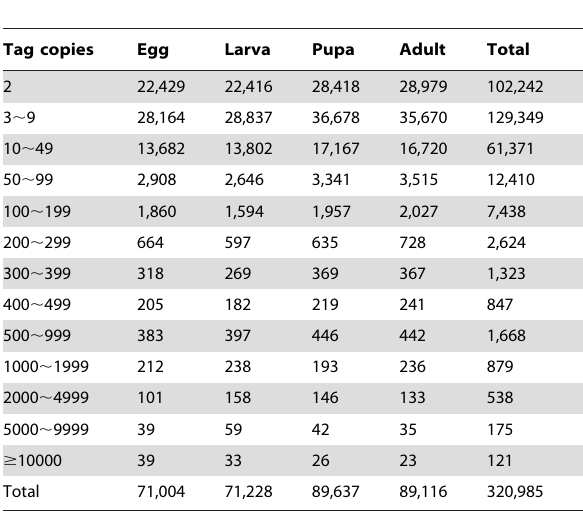
Table 4. The distribution of clean tag copy number in the four developmental stages of O. furnacalis .